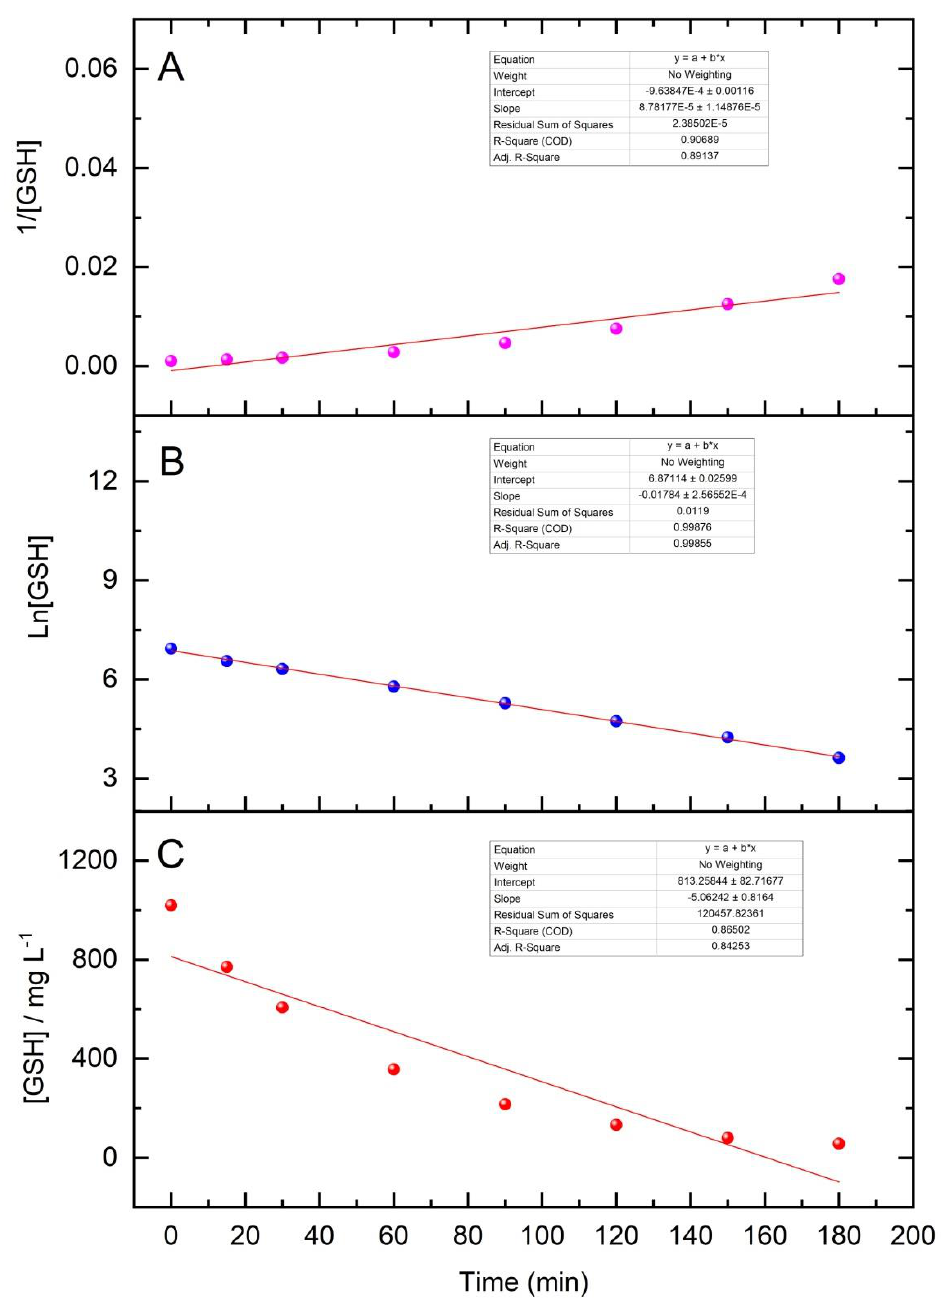
Figure 6. Kinetic models of the oxidative degradation of GSH by ZF; ( A ) zero order, ( B ) first order and ( C ) second order.